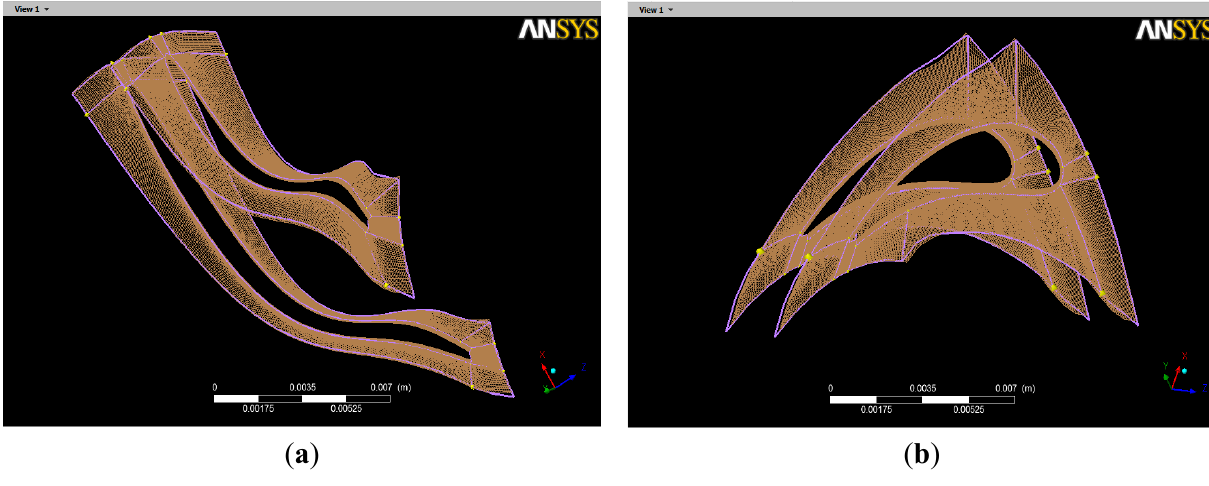
Figure 15. Example of the resultant mesh of the rotor ( a ) and stator ( b ) passage.